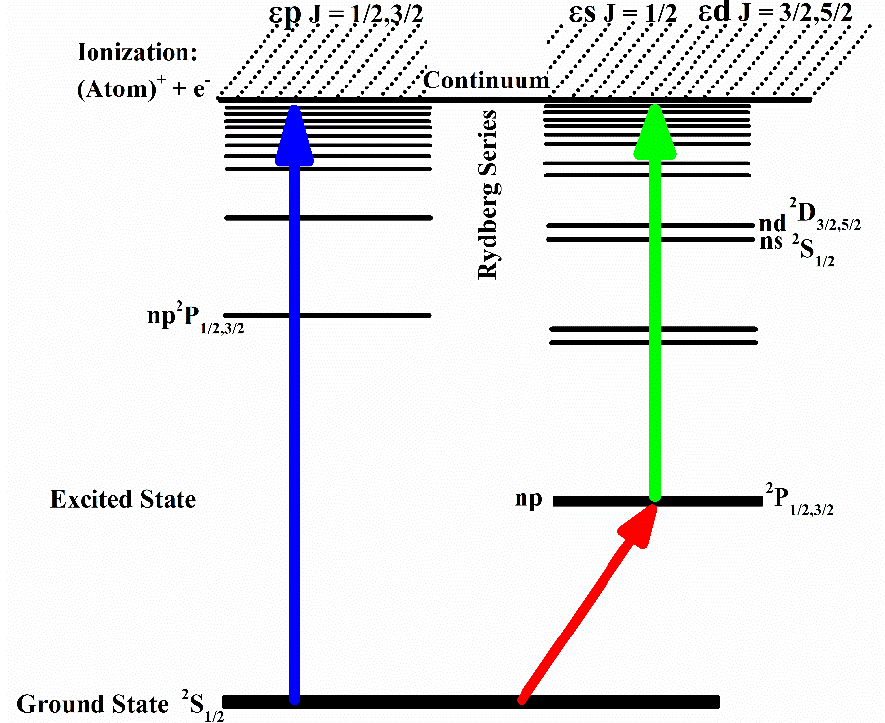
Figure 1. Schematic diagram of the excitation from the ground state and two-step laser excitation